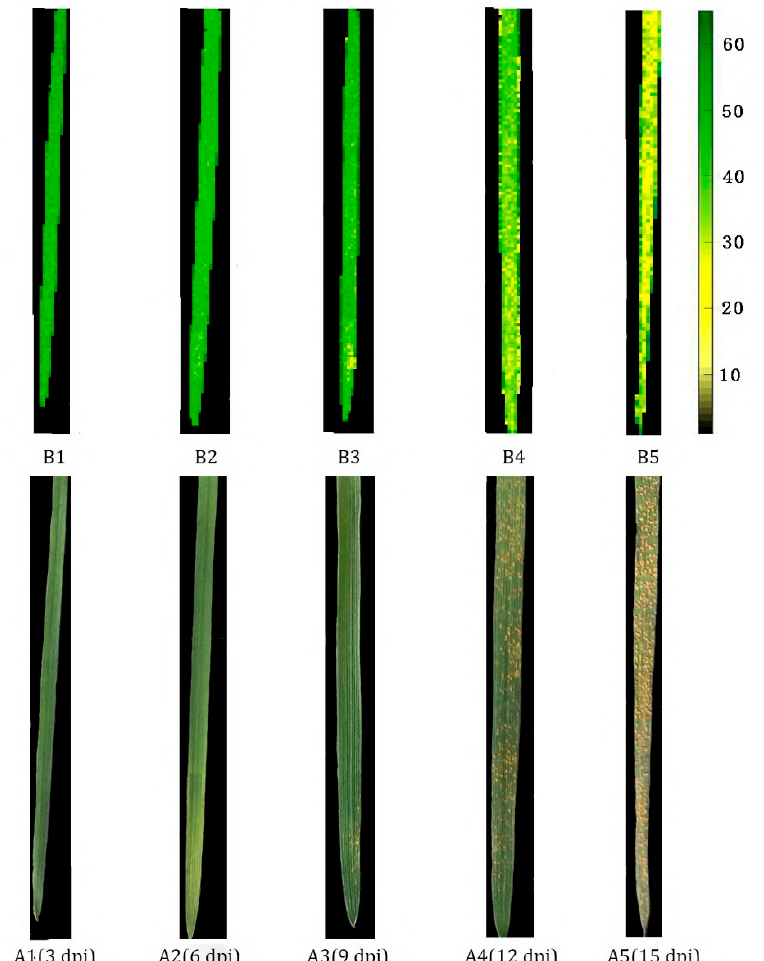
Figure 8. Chlorophyll distribution of wheat leaves during different days past inoculation.